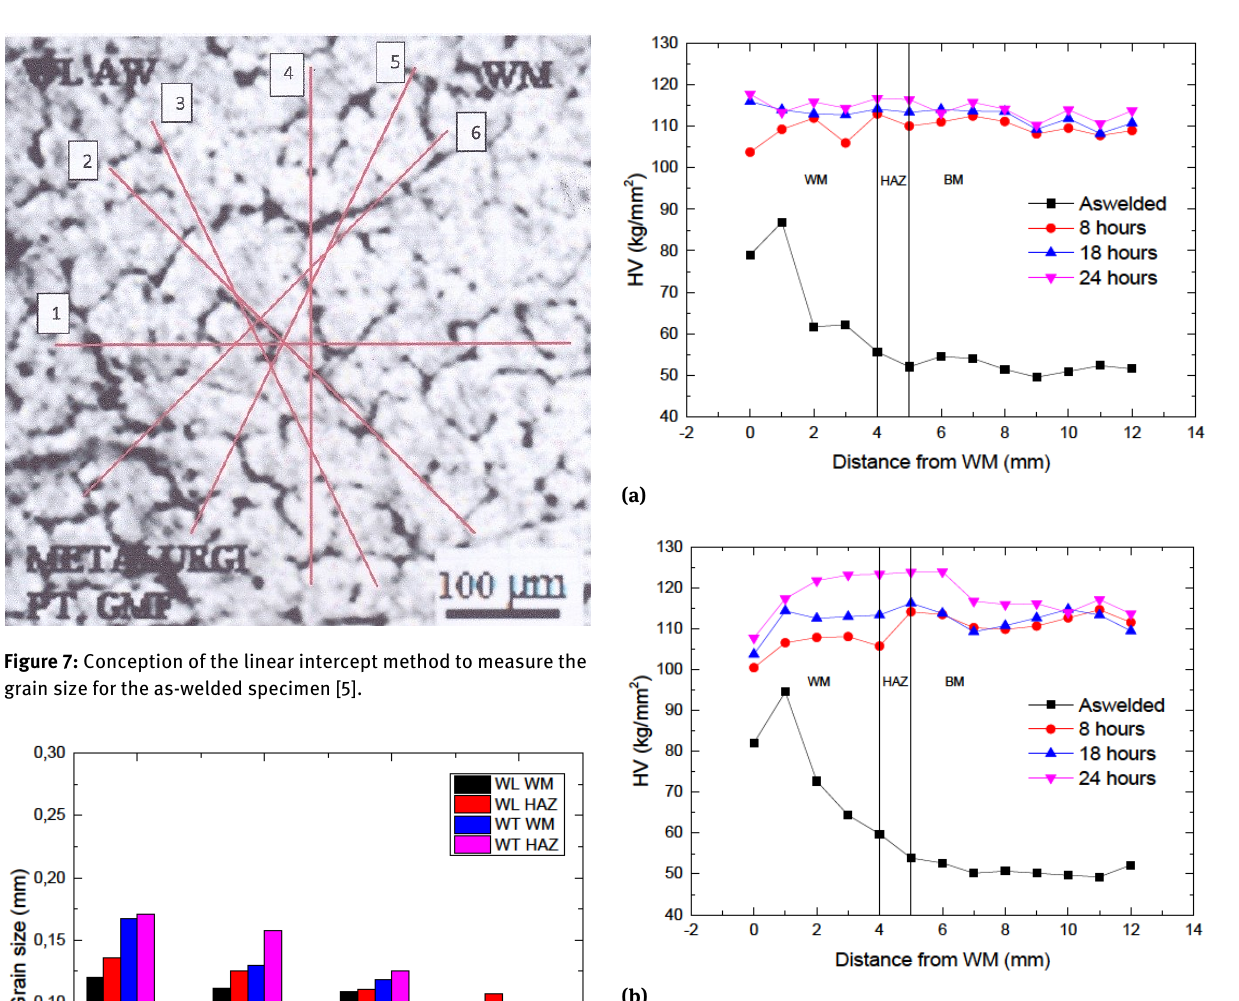
Figure 9: Vickers micro-hardness profiles distribution across the WM specimen; (a) Longitudinal, and (b) Transversal